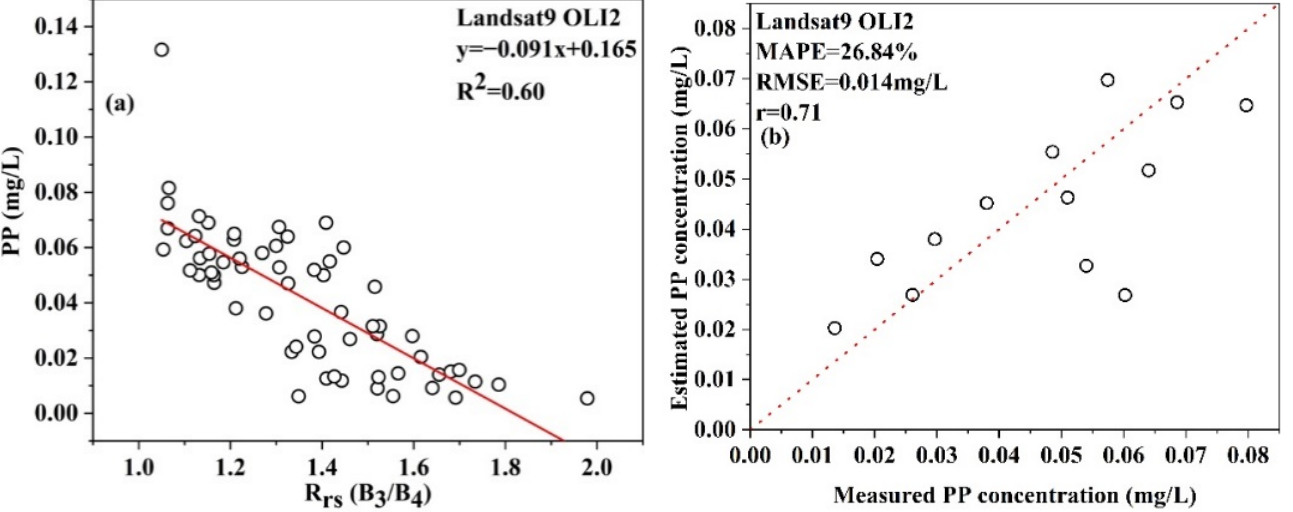
Figure 7. ( a ) The PP and R rs fitting curve; ( b ) comparison of the measured PP values and those estimated based on measured hyperspectral data.